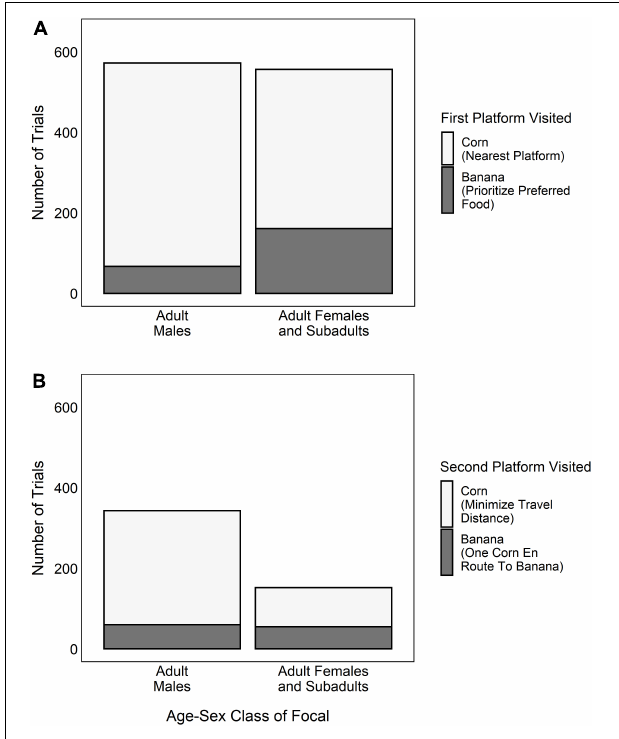
FIGURE 5 | The number of trials in which adult males and adult females/subadults each chose different food rewards when making (A) Decision 1 (i.e., which platform to visit first), and (B) Decision 2 (i.e., which platform to visit second, if they had chosen their nearest corn platform in Decision